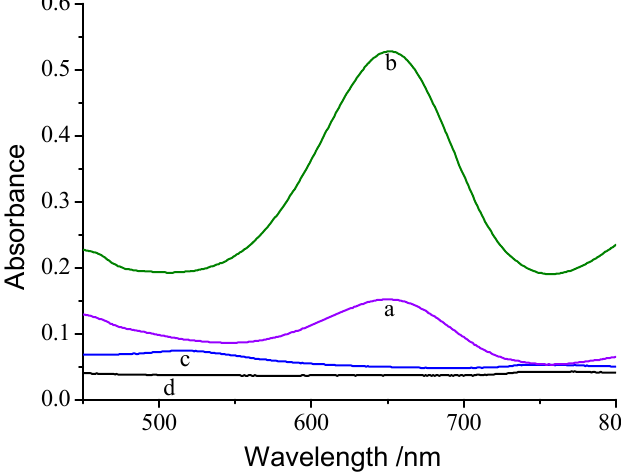
Figure 2. UV–vis spectra of AuNPs ‐ H T7 + TMB ‐ H 2 O 2 reaction solution (a) before and (b) after capturing CH 3 Hg + and Hg deposition, (c) AuNPs ‐ H T7 solution and (d) TMB ‐ H 2 O 2 substrate.